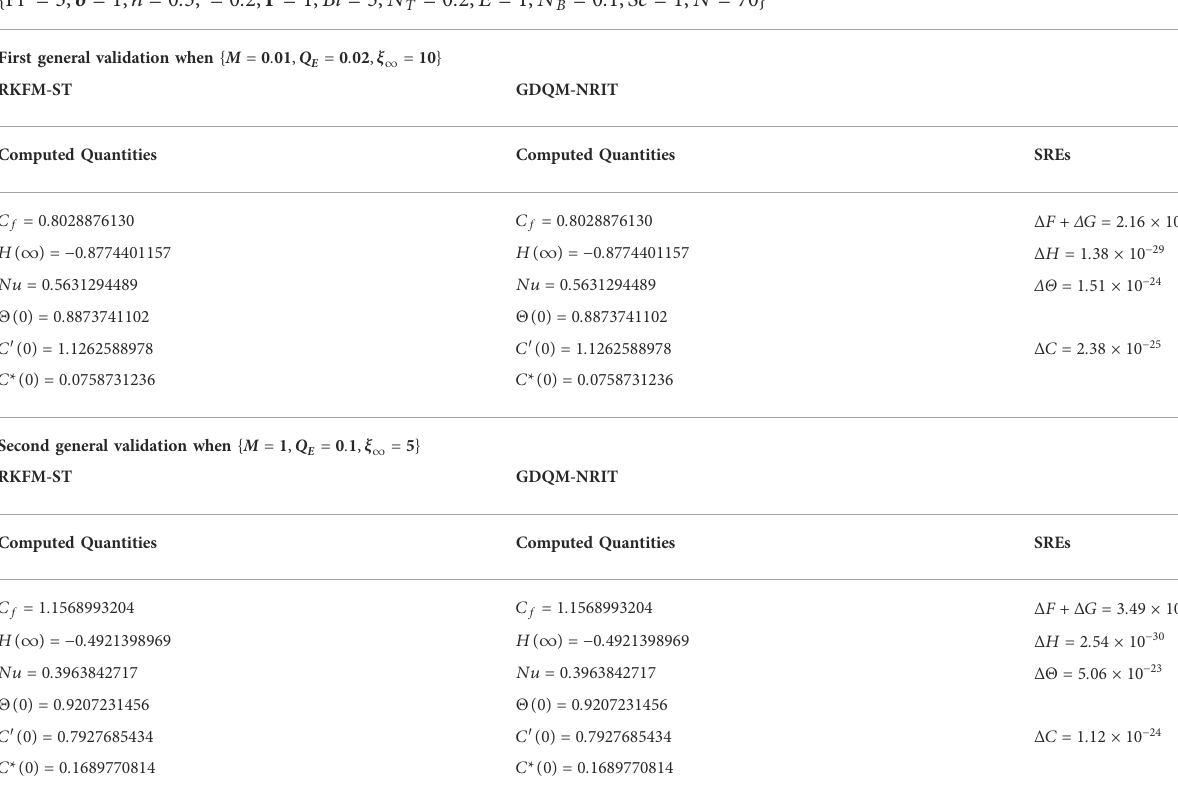
TABLE 3 General validation of GDQM- NRIT algorithm via RKFM-ST results. { Pr (cid:3) 3 , δ (cid:3) 1 ,n (cid:3) 0 . 5 , (cid:3) 0 . 2 , Γ (cid:3) 1 , Bi (cid:3) 5 , N